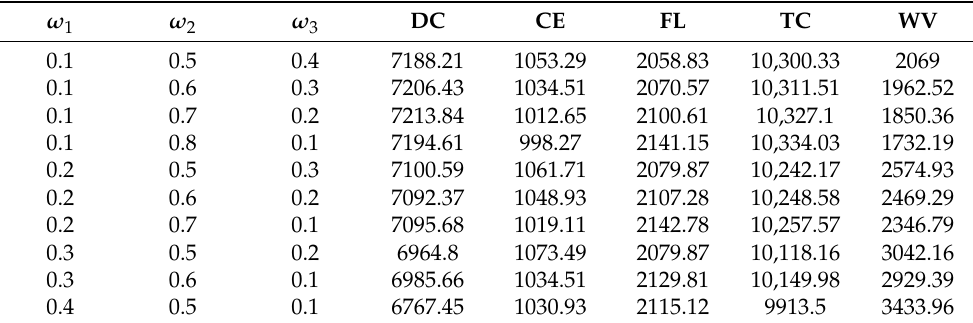
Table 6. Experimental results of different weight combination of distribution cost, carbon emission cost, and freshness